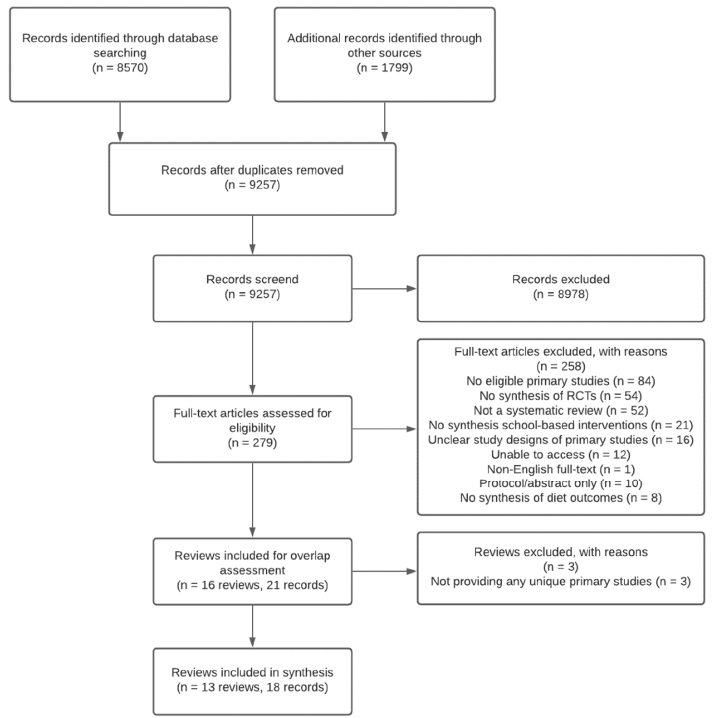
Figure 1. PRISMA diagram of the flow of included studies.